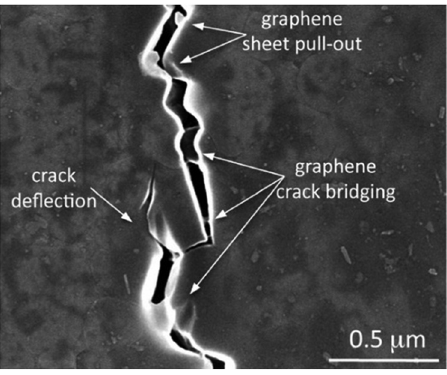
Figure 3: Toughening mechanism in graphene ceramic matrix com - posite [ 22 ] .